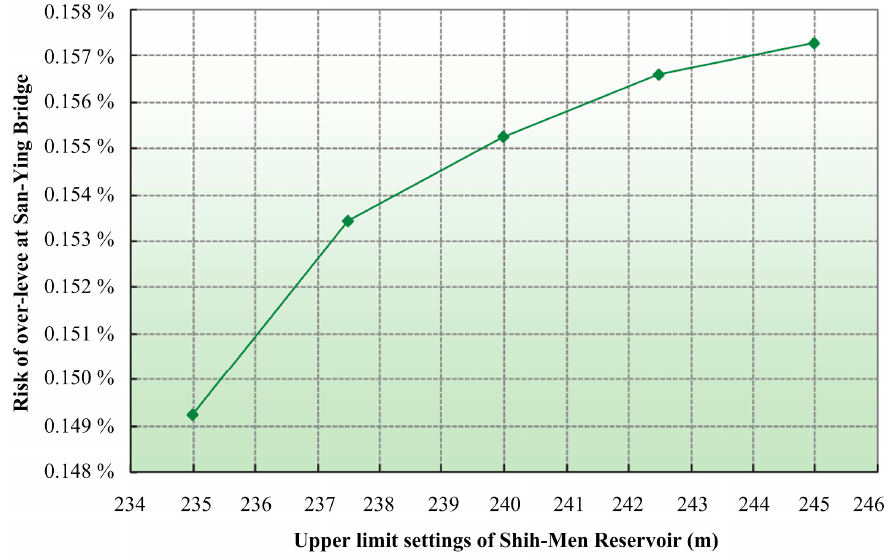
Figure 11. Over-levee risk analysis of San-Ying Bridge in a typhoon period for different upper limit settings of Shih-Men Reservoir. settings of Shih-Men